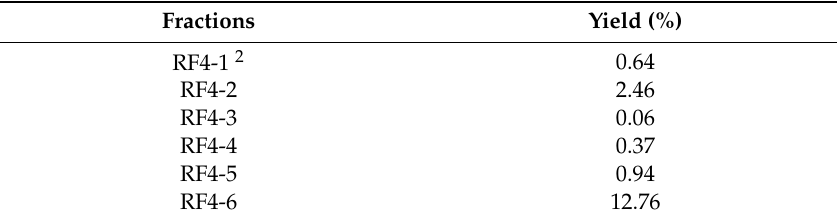
Table 6. Yields of melanoidin fractions with di ff erent molecular weights (MWs). 1